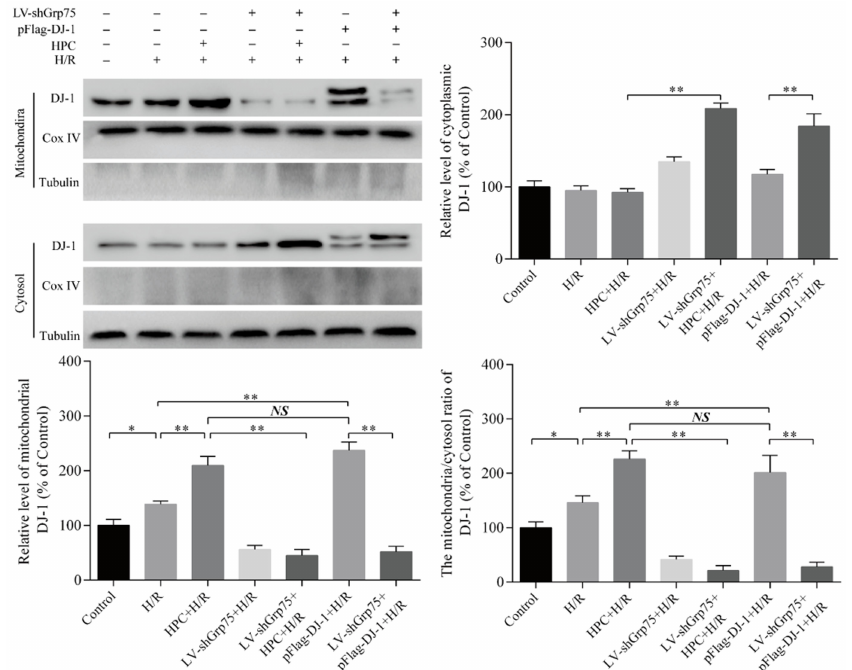
Figure 4. E ff ect of inhibiting Grp75 expression on hypoxic preconditioning (HPC)-induced DJ-1 translocation from cytosol to mitochondria in H9c2 cells subjected to hypoxia / reoxygenation (H / R). H9c2 cells were infected by lentiviral (LV) vectors LV-shGrp75 for 72 h and then subjected to HPC 24 h prior to H / R or transfected with pFlag-DJ-1 for 48 h followed by H / R. Subsequently, DJ-1 mitochondrial translocation was analyzed by Western blot. Cox IV and Tubulin served as loading and purity controls for mitochondrial and cytoplasmic fraction, respectively. The mitochondria:cytosol ratio of DJ-1 was used as indexes of DJ-1 translocation from cytosol to mitochondria. Representative Western blots from three independent experiments and bar graphs from their densitometric analyses are shown. Values are mean ± SD. * p < 0.05, ** p < 0.01 as indicated on the figure. NS indicates no